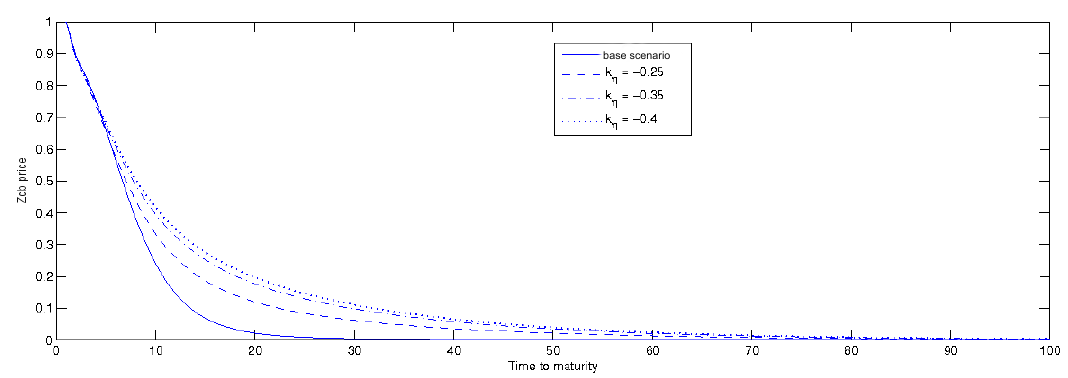
Figure 6. Zero coupon bond price in different hypothetical levels of k η .